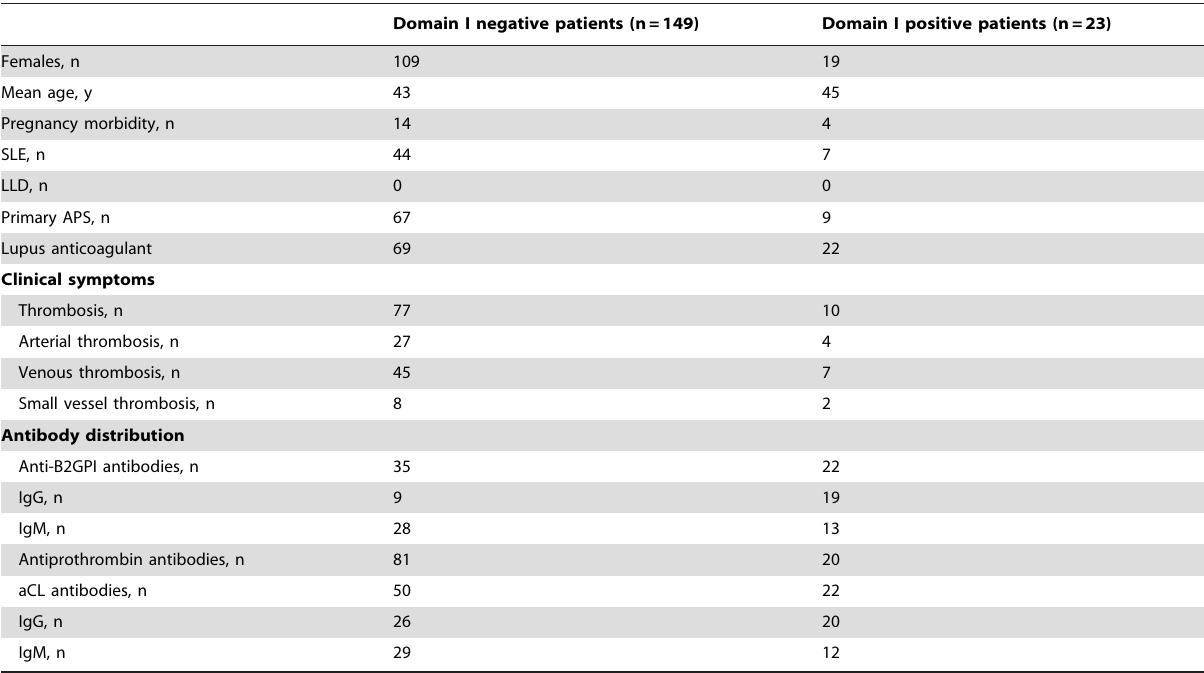
Table 3. Clinical and serological characteristics of cohort 2 (172